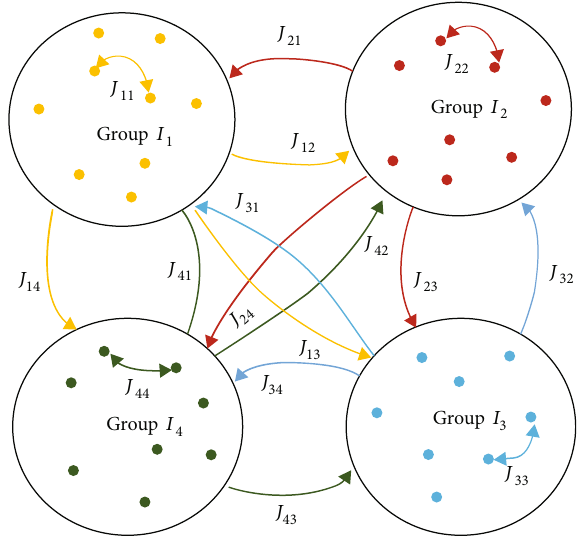
Figure 1: A representation of the interaction network for the model ( I , I , I , and I are the subgroups of the reference group. Within I 1 2 3 4 (resp. I , I , I ), individuals feel a mean- fi eld interaction with 2 3 4 (resp. J , J , and J ). Subgroup I in fl uences the coupling J 11 22 33 44 1 , J , J other subgroups with coupling strength ( J 12 13 14